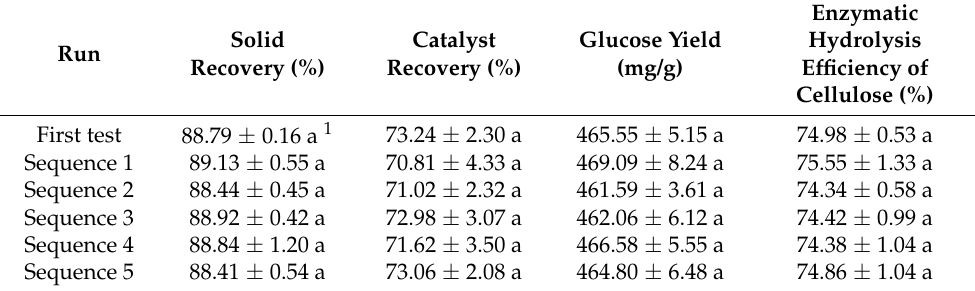
Table 3. Recovery rate and reuse effect of PTA catalyst.